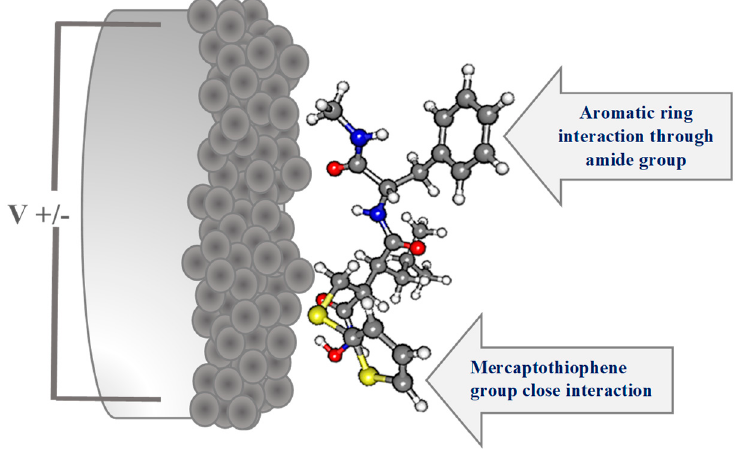
Figure 3. Optimized structure of BB-94 at B3LYP/6-31G(d,p) level of theory and suggested adsorption geometry of BB-94 on roughened Ag electrode surface.